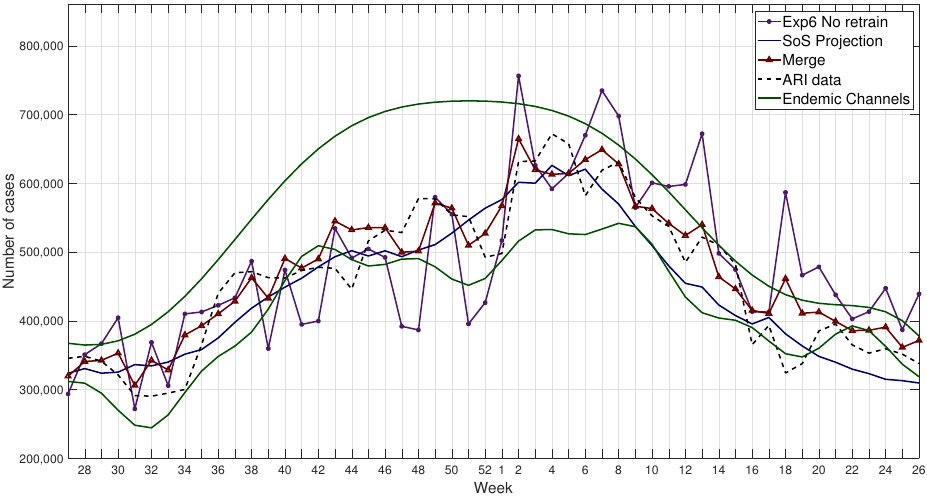
Figure A3. Results from the model for the year 2018–2019 compared with the real values for ARI